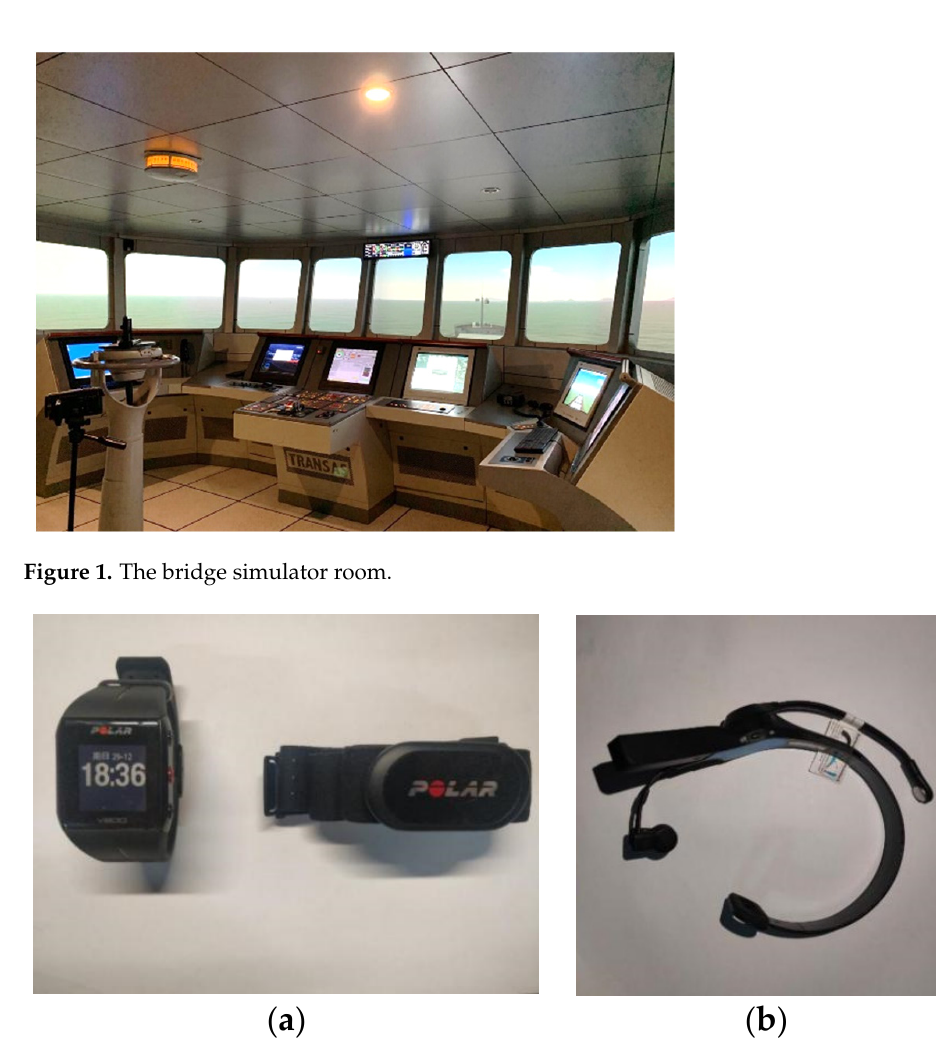
Figure 2. The experimental equipment ( a ) polar V800 watch with H10 chest strap ( b ) NeuroSky Mindwave wireless EEG headset.